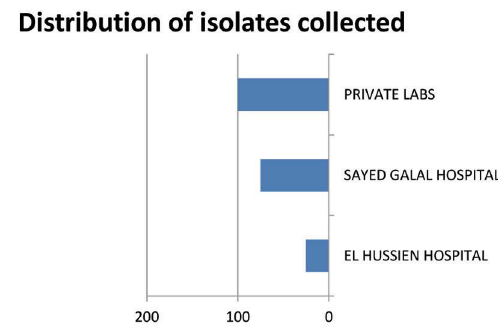
Fig 1. Distribution of micro-organisms isolated from different sources.